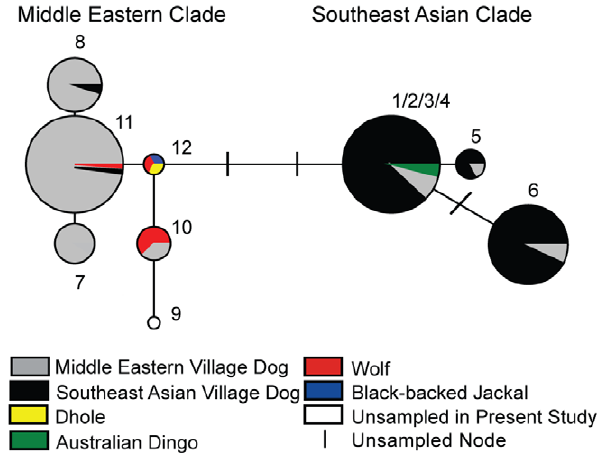
Figure 1. Y chromosome SNP haplotype network of village dogs and wild canids. Samples include Southeast Asian village dogs ( n =159), Australian dingoes ( n =5), Middle Eastern village dogs ( n =136), wolves ( n =7), dhole ( n =1) and black-backed jackal ( n =1), which form a primarily Middle East village dog clade, including wolf and outgroup taxa, and a primarily Southeast Asian village dog clade. The 8 haplotypes were based on 11 SNP mutations and included 6 found previously (haplotypes 1–9, [25]) and 3 new ones (haplotypes 10–12; reflected previously as unsampled nodes). Haplotypes 1–4 could not be distinguished based on the 11 sites genotyped in our study. Size of circle is proportional to sample size. Haplotypes of 48 village dogs were incomplete and imputed based on 8–10 SNPs and associations with similar STR haplotypes (Table S7).